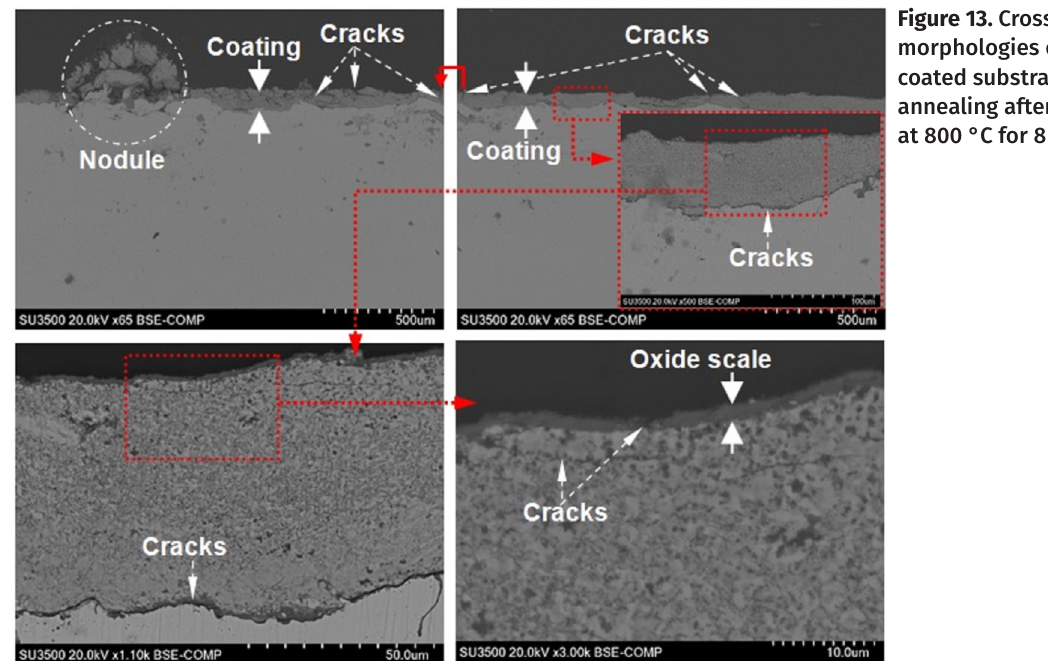
Figure 13. Cross-section morphologies of the coated substrate without annealing after oxidation at 800 °C for 8